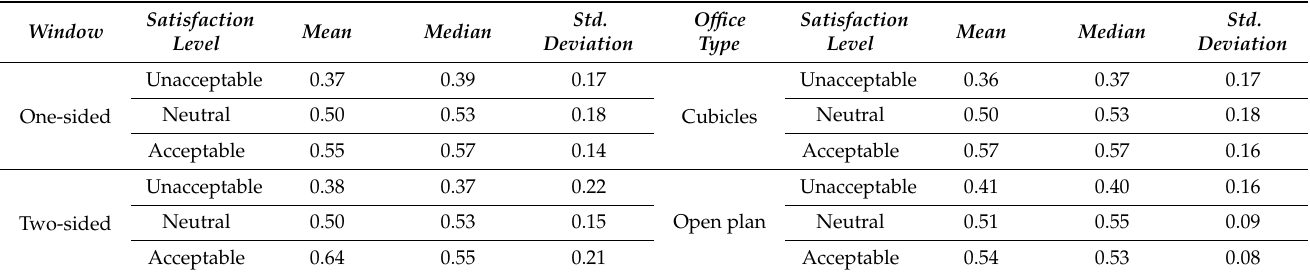
Table 7. Satisfaction level of DTR in the studied